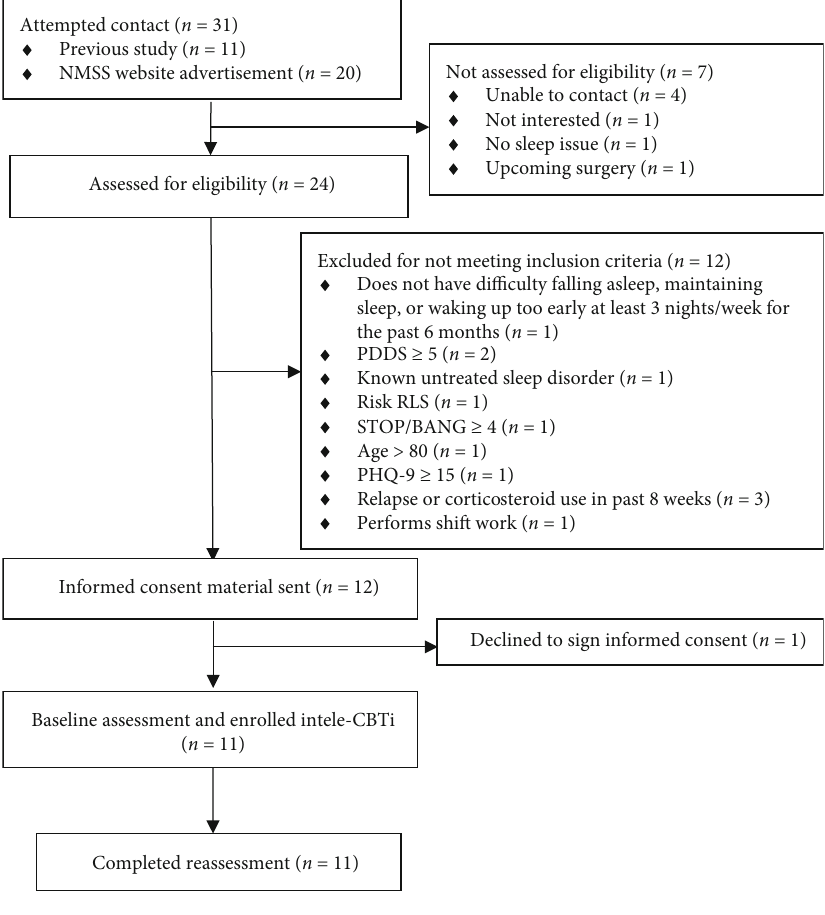
Figure 1: Study design. Table 2: Primary and secondary outcomes at baseline (pre), reassessment (post), change score, and e ff ect size. Data reported as mean (standard deviation). ISI: Insomnia Severity Index; PSQI: Pittsburgh Sleep Quality Index; MFIS: Modi fi ed Fatigue Impact Scale; FSS: Fatigue Severity Scale; SSES: Sleep Self-E ffi cacy Scale; SOL: sleep onset latency; SE: sleep e ffi ciency; TST: total sleep time; PHQ-9: Patient Health Questionnaire, 9 items; GAD-7: Generalized Anxiety Disorder Assessment, 7 items; MSIS-29: Multiple Sclerosis Impact Scale, 29 items; ES: e ff ect